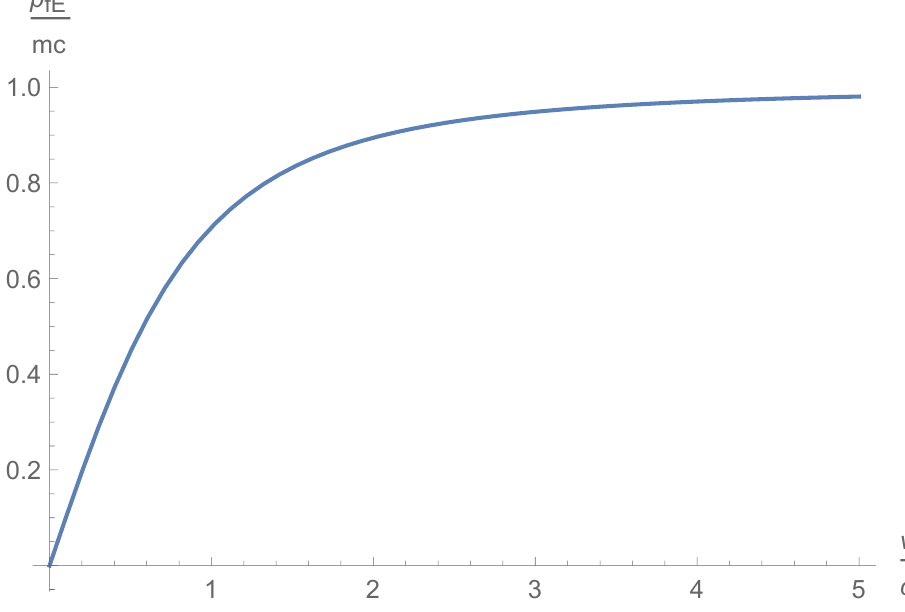
Figure 3. Free momentum for Euclidean